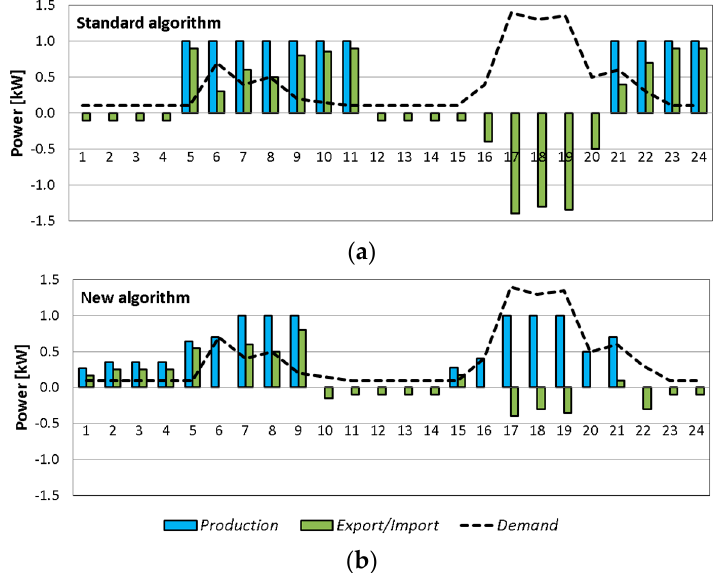
Figure 8. Profiles of the electricity demand and production in the mCHP system during winter season depending on the control algorithm used: ( a ) standard algorithm, and ( b ) new algorithm.